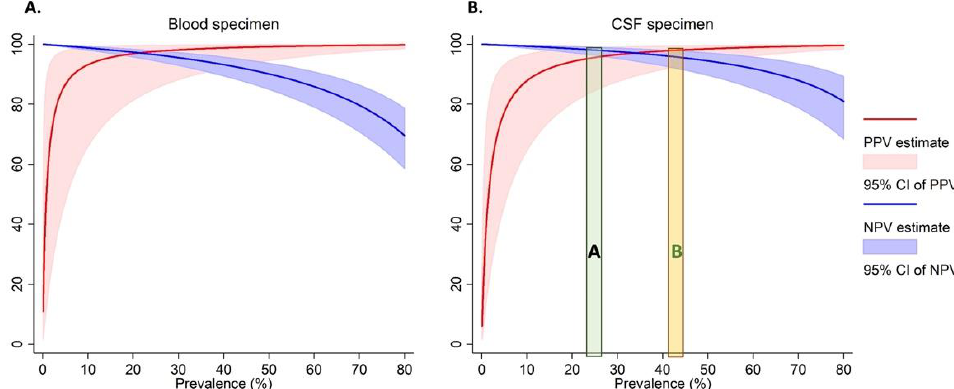
Figure 1. The Positive and negative predictive values for the detection of Nm in dried blood (A) and CSF ( B ) specimens. The green area labelled “A” represents the prevalence of N. meningitidis among tested specimens observed among previous meningococcal outbreaks in Niger [5] and The Gambia [20]. The orange area labelled “B” represents the prevalence of N. meningitidis among tested specimens observed among previous meningococcal outbreaks in Nigeria [4].